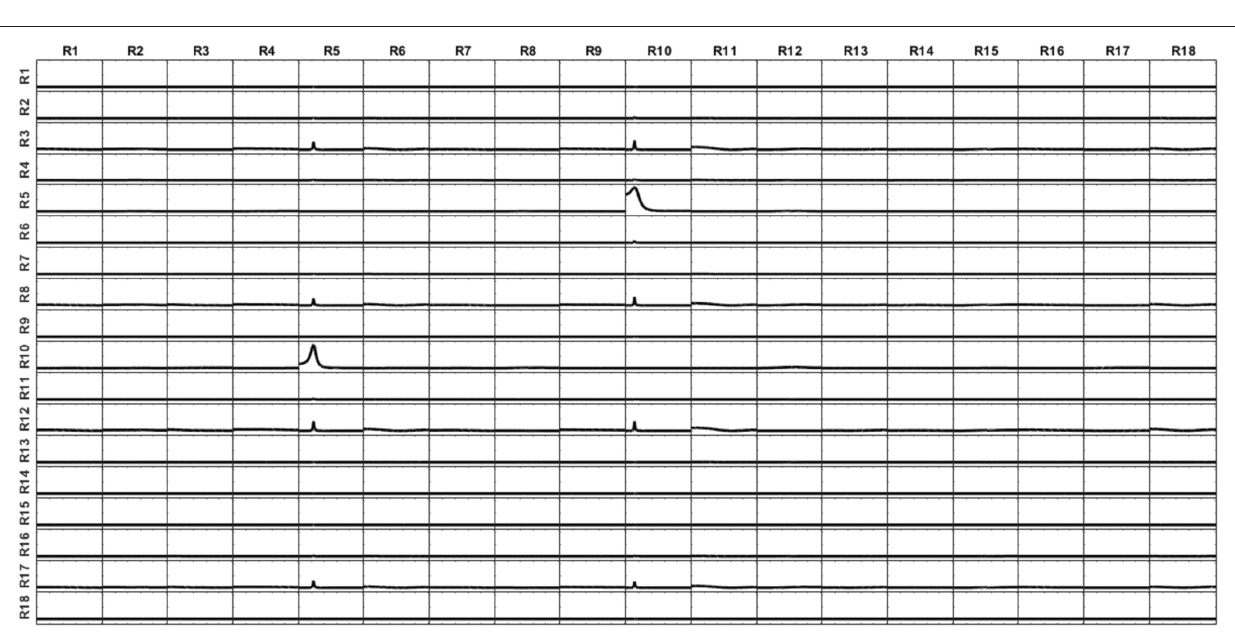
FIGURE 14 | iCoh connectivity for the setting of current at the surface voxels reconstructed by the superficial lead field and sLoreta. The patterns are recovered with great accuracy; only some small artifacts randomly appear, due to the Gaussian white noise added to the simulated signals. Remember that in this simulation, the voxels at the surface are a subset of the voxels in the